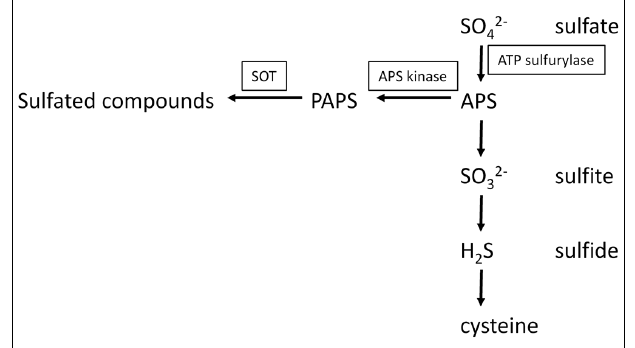
FIGURE 3 | Biosynthesis ofAPS and PAPS and the connection of primary and secondary sulfur